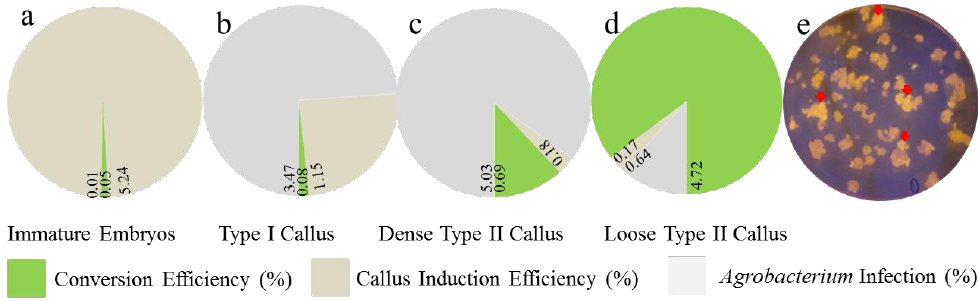
Figure 1. Agrobacterium transformation efficiency based on different states of the callus. ( a ) Conversion efficiency and loss rate for callus induction and Agrobacterium on immature embryos. Columnar volume represents material that is transiently transformed; The green plate represents conversion efficiency rate; Brown plate represents the callus loss caused by callus induction. The grey plate represents the callus loss caused by Agrobacterium infection; ( b ) Conversion efficiency and loss rate for callus induction and Agrobacterium on Type I callus. The green plate represents conversion efficiency rate; Brown plate represents the callus loss caused by callus induction. The grey plate represents the callus loss caused by Agrobacterium infection; ( c ) Conversion efficiency and loss rate for callus induction and Agrobacterium on Dense Type II callus. The green plate represents conversion efficiency rate; Brown plate represents the callus loss caused by callus induction. The grey plate represents the callus loss caused by Agrobacterium infection; ( d ) Conversion efficiency and loss rate for callus induction and Agrobacterium on Loose Type II callus. The green plate represents conversion efficiency rate; Brown plate represents the callus loss caused by callus induction. The grey plate represents the callus loss caused by Agrobacterium infection; and, ( e ) Callus phenotype on DR-46B Dark Reader transilluminator in darkness. Callus with green fluorescence are indicated by the red arrow.